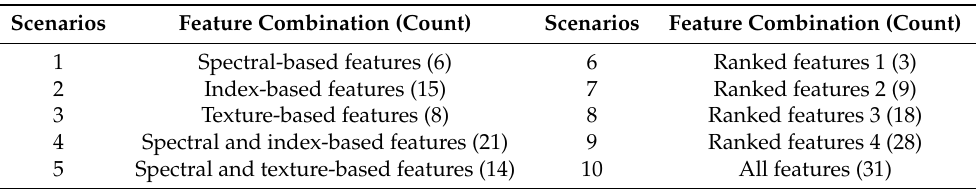
Table 3. Different scenarios for feature optimization.